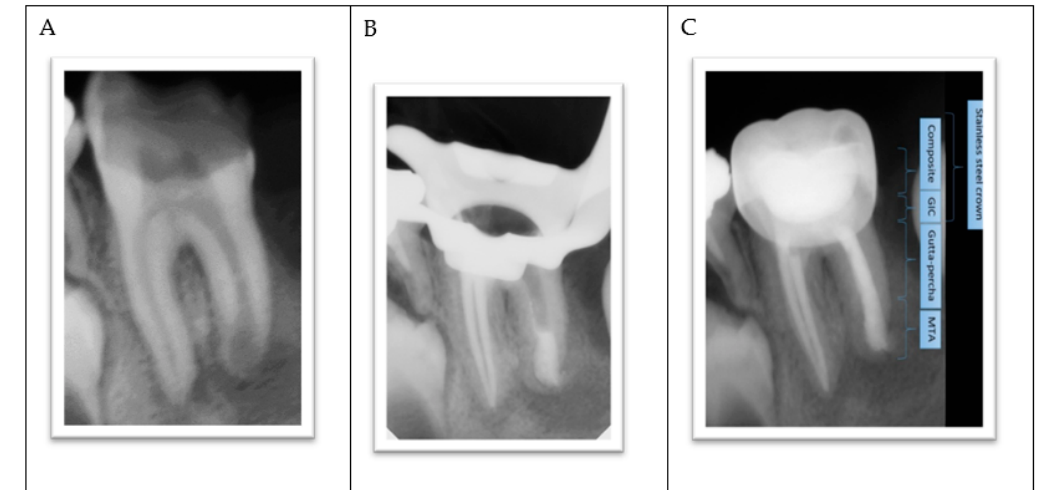
Figure 4. ( A ) Apical lesions with extensive decay in tooth #36. ( B ) Verifying the placement of the MTA plug. ( C ) Completed root canal treatment and placement of a metallic crown.